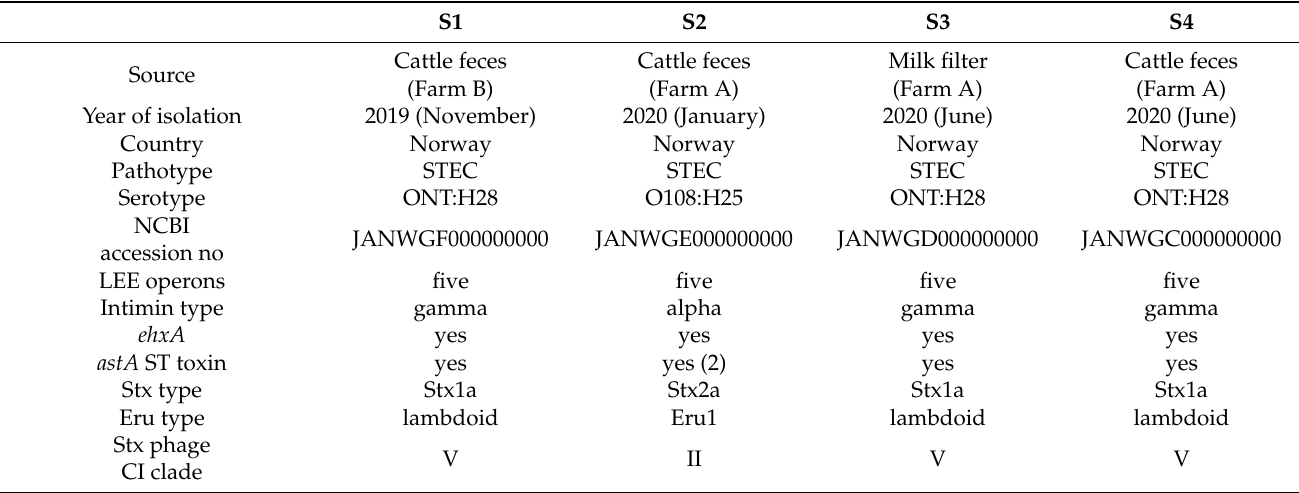
Table 1. Characteristics of the Shiga toxin-producing E. coli isolated from dairy farms located in the southeast of Norway